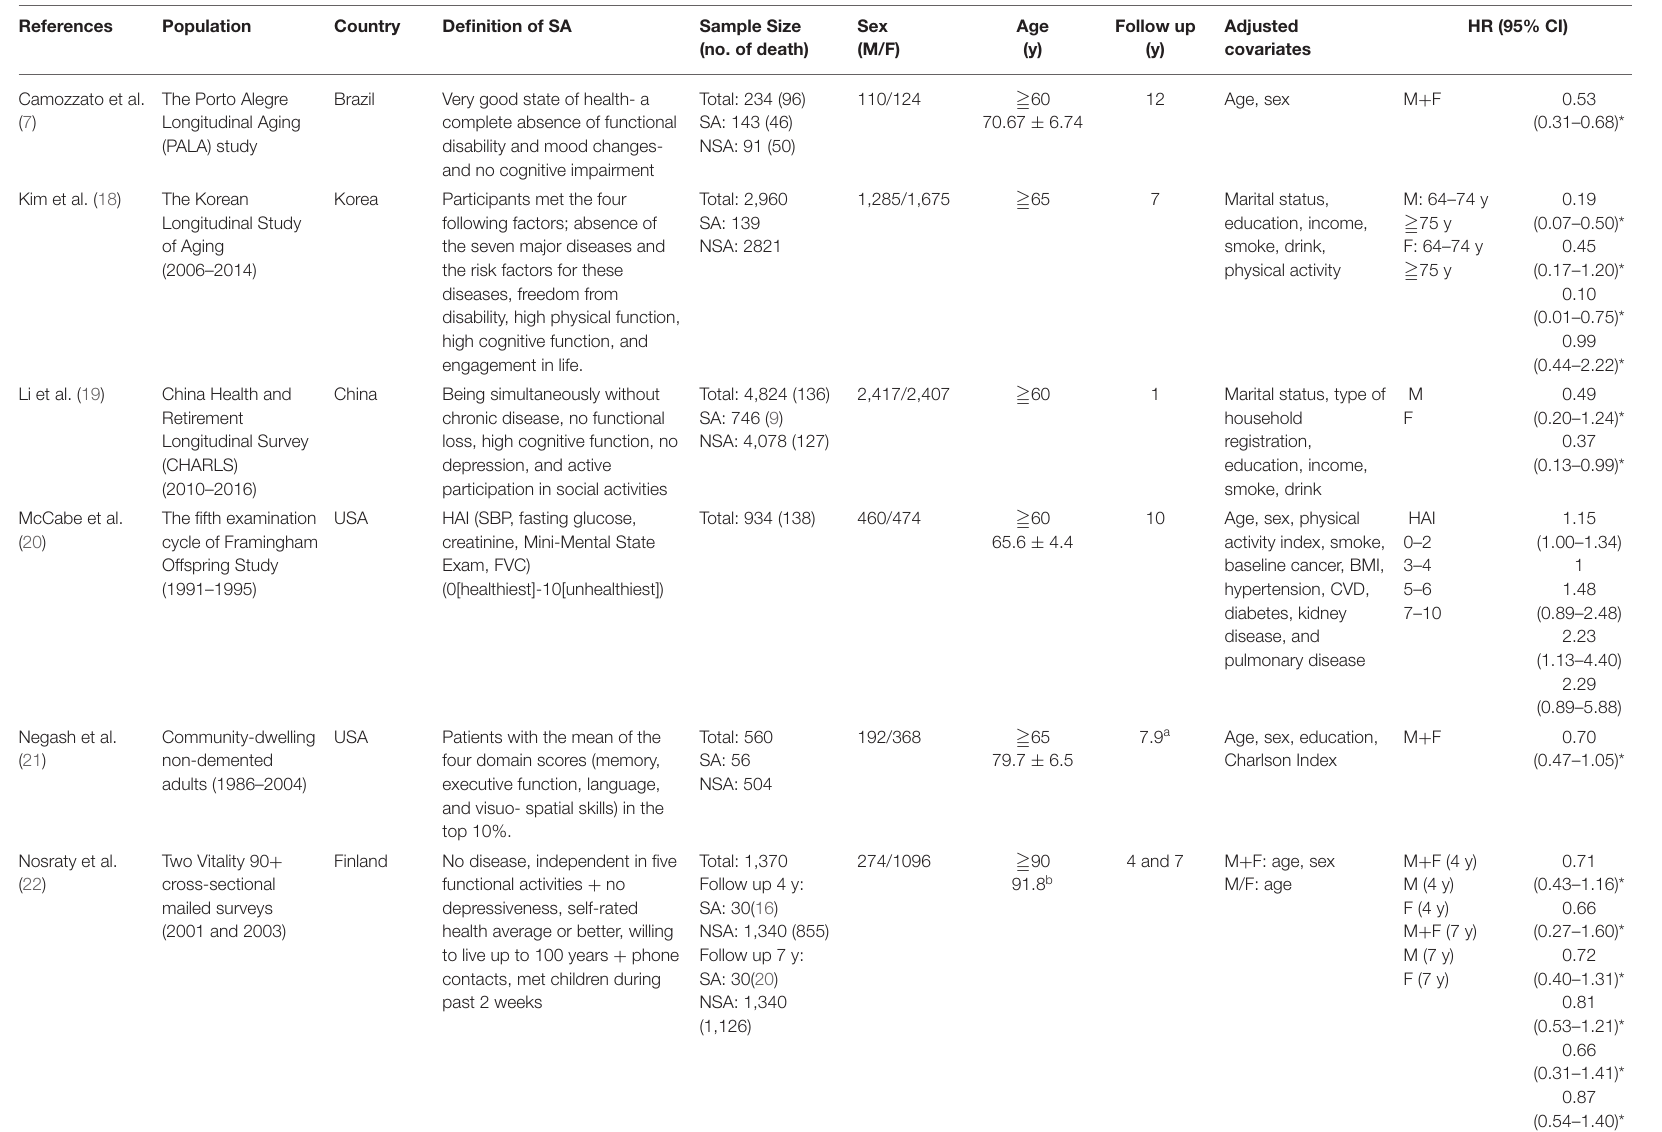
TABLE 1 | Characteristics of the included